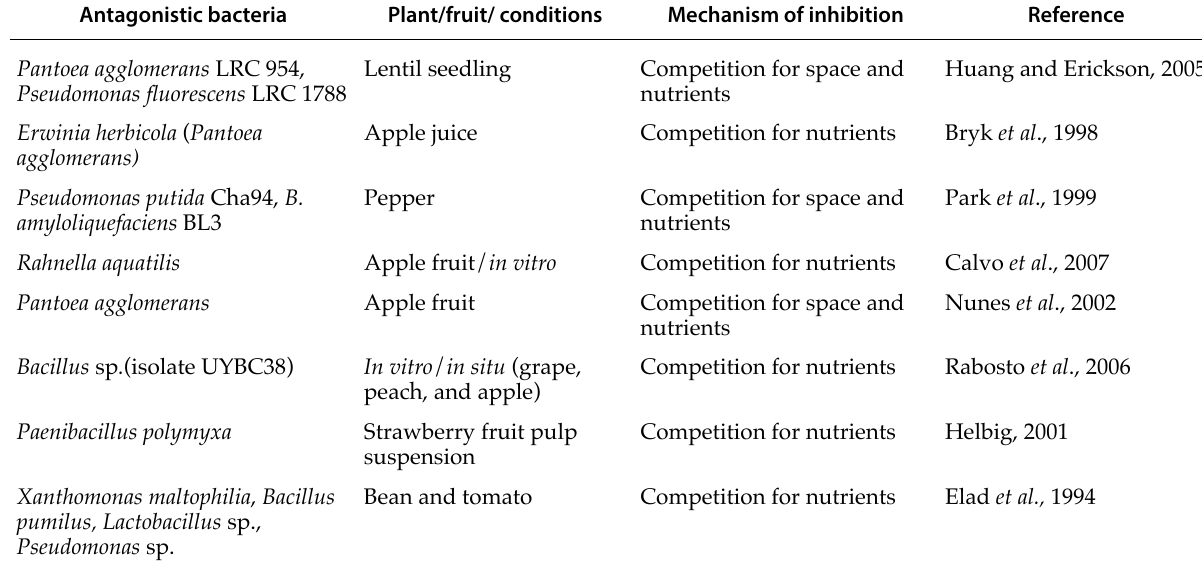
Table 2. Examples of bacteria providing biocontrol of Botrytis cinerea , through competition for space and/or nutrients. Antagonistic